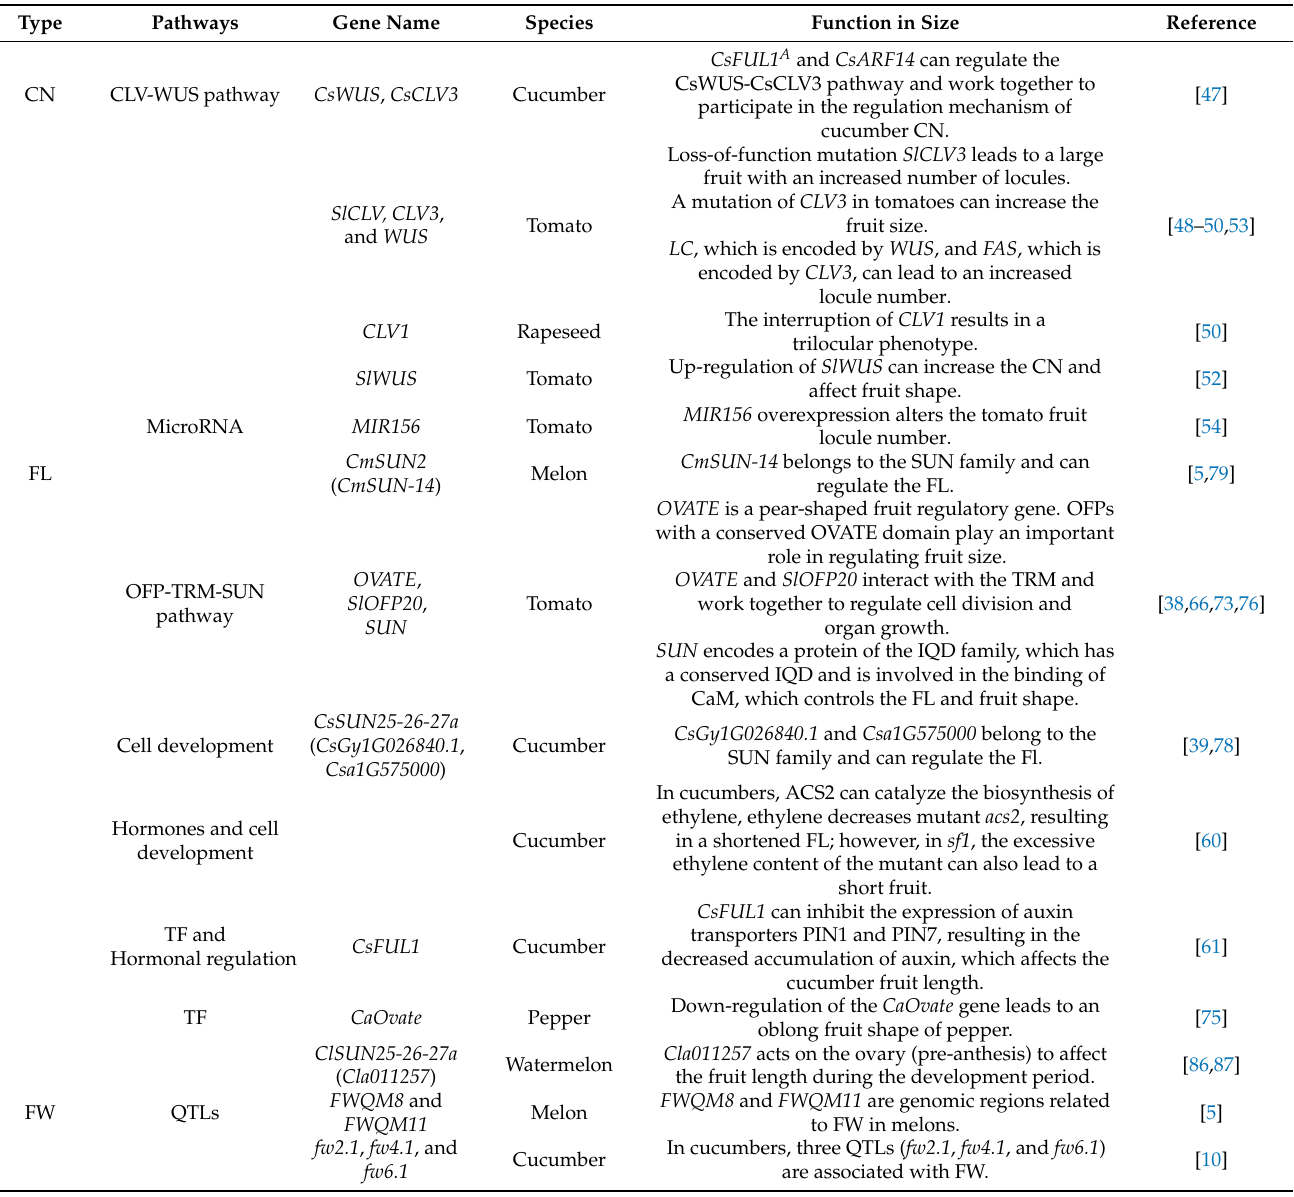
Table 1. Genes involved in the fruit size regulation of